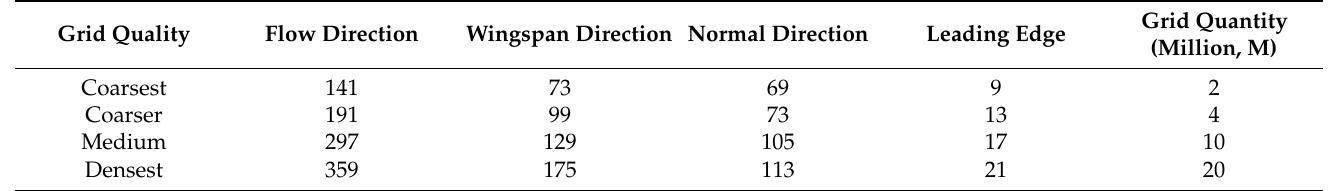
Table 1. Parameters of the 4 sets of grids.